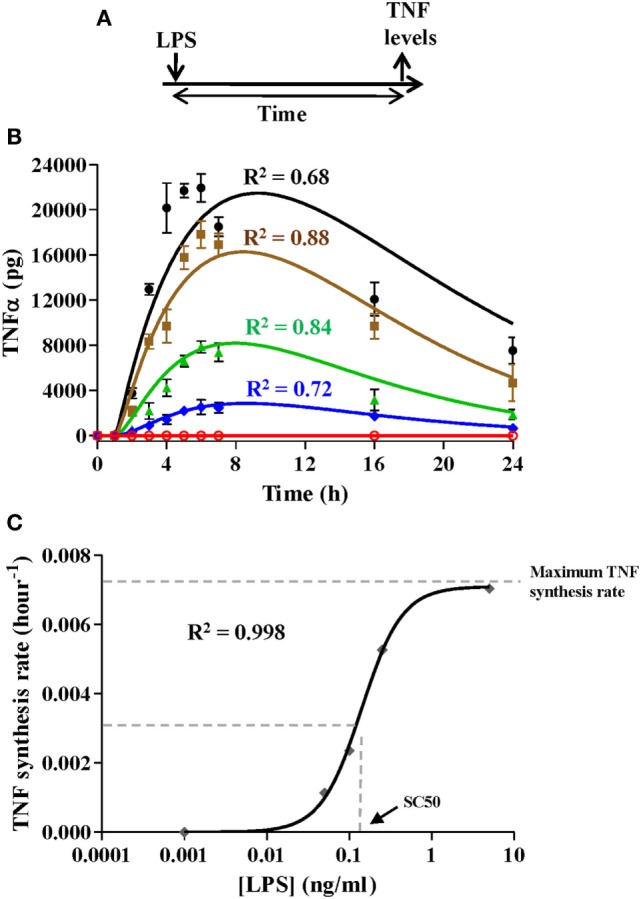
Simulation of various proinflammatory scenarios. Experimental data were obtained from cultures of 106 monocytes isolated from healthy volunteers challenged with lipopolysaccharides (LPSs) as described in (A) at a concentration of 5, 0.25, 0.1, 0.05 ng/ml, or not challenged. Tumor necrosis factor (TNFα) levels were quantified in the monocyte cultures at the indicated times using cytometric bead array assays and were graphically represented (B) as black circles (LPSs 5 ng/ml), brown squares (LPSs 0.25 ng/ml), green triangles (LPSs 0.1 ng/ml), blue diamonds (LPSs 0.05 ng/ml), or red circles (not challenged). Real data were expressed as the mean ± SEM (n = 3 healthy volunteers). The model was programmed with 106 monocytes in the resting monocyte state and the same initial LPSs concentrations. Outputs from the model simulation for TNF state were graphically represented (B) as black line, LPSs 5 ng/ml; brown line, LPSs 0.25 ng/ml; green line, LPSs 0.1 ng/ml; blue line, LPSs 0.05 ng/ml; or red line, not challenged. The coefficient of determination R2 is presented in each case to measure the goodness of the adjustment. (C) Adjustment of the TNF synthesis rate Hill function. The black line corresponds to the function optimized to fit the estimated TNF synthesis rates from Table 6. [LPS] refers to the LPSs concentration in the medium.